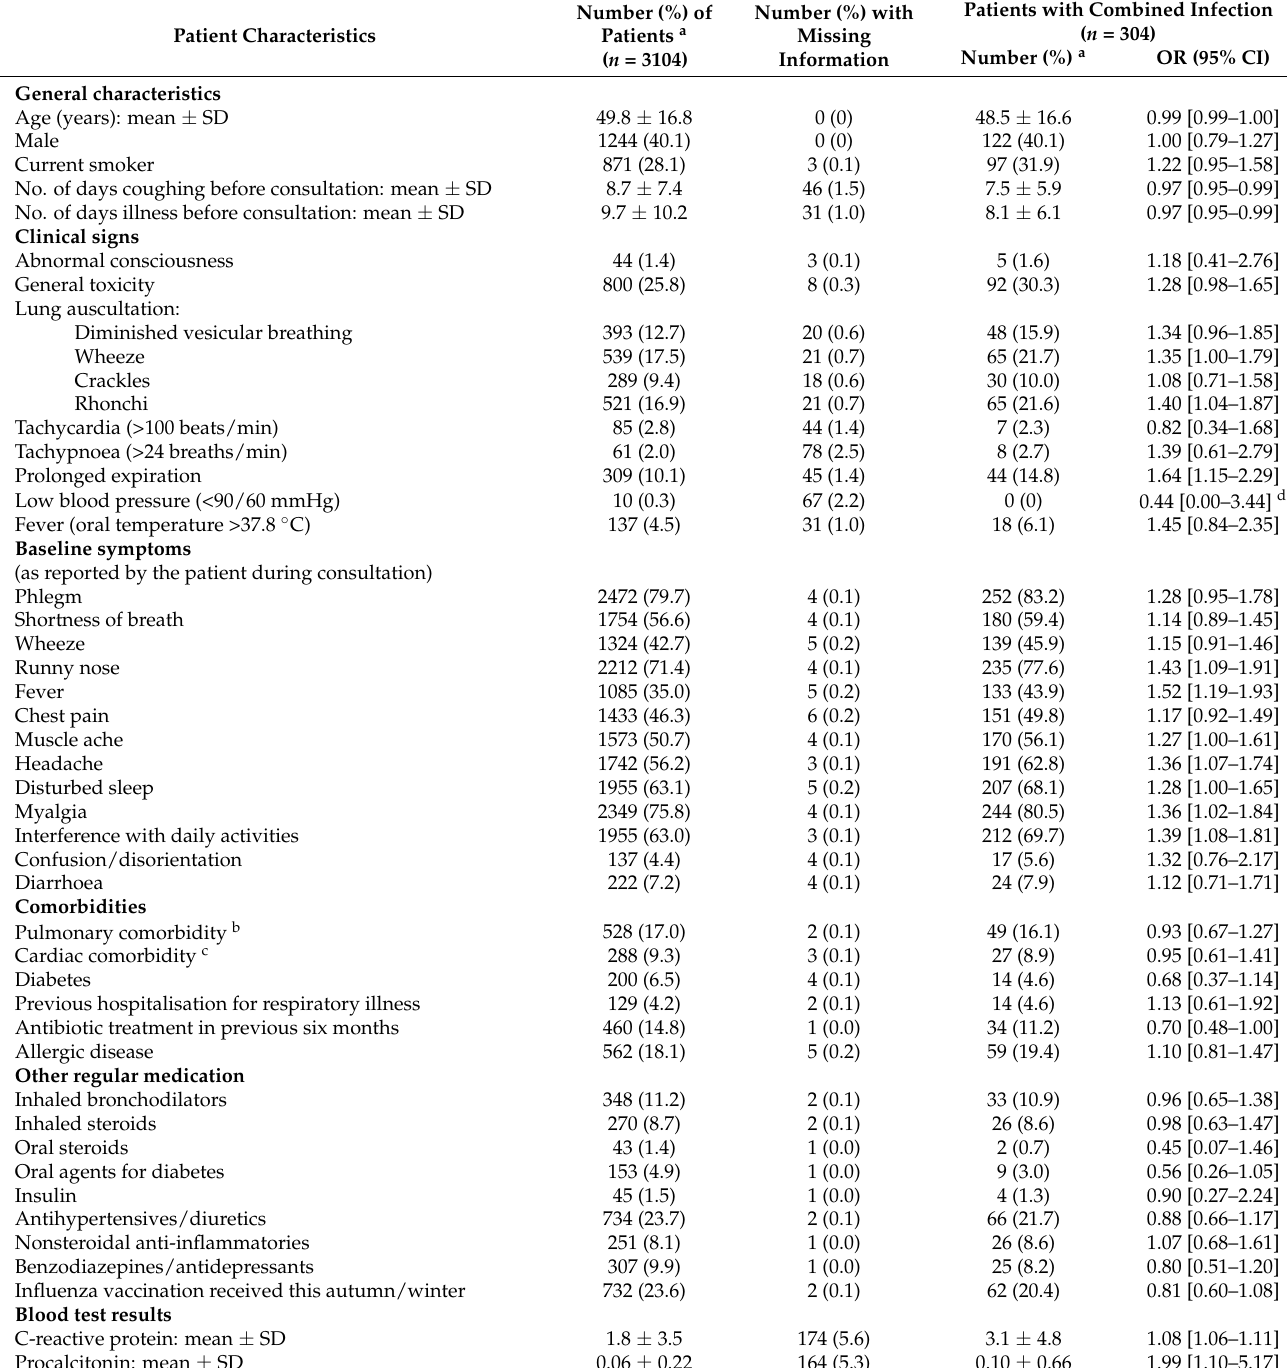
Table 1. Overview of patient characteristics and their association with the odds of a combined infection in adults presenting to primary care with acute